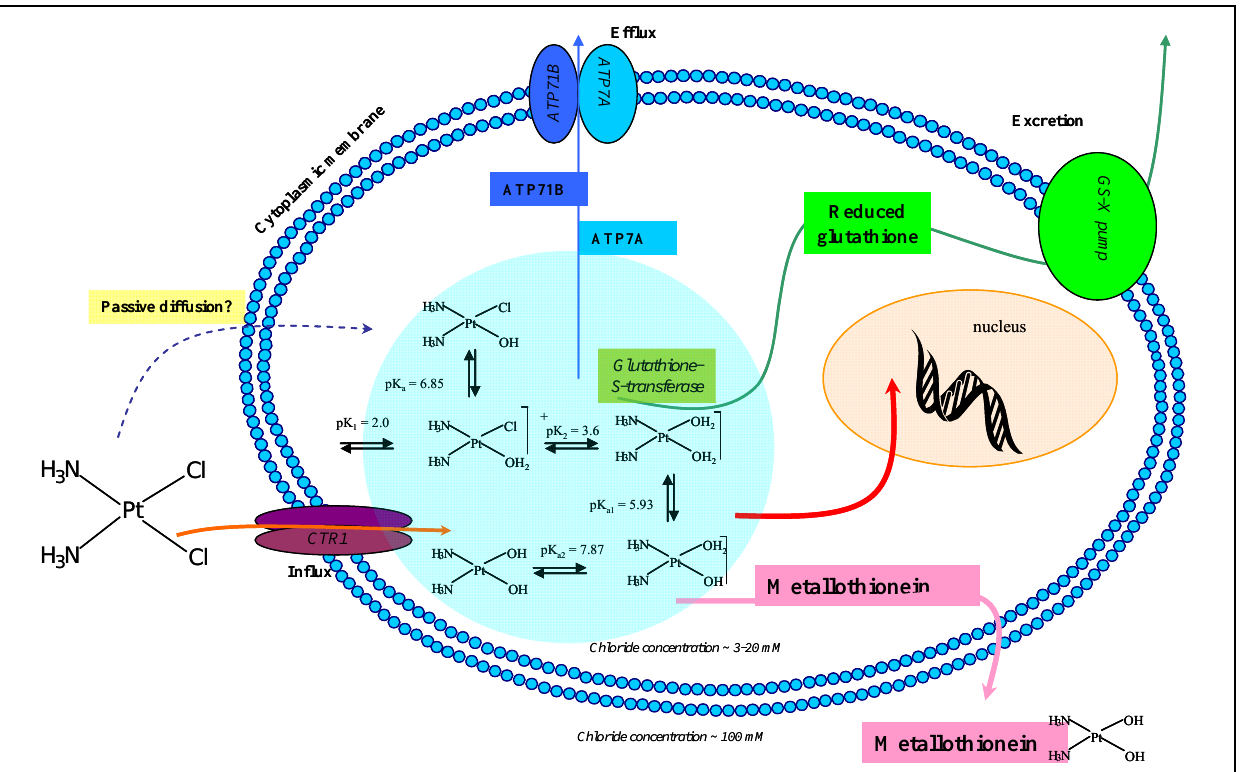
Figure 1. A simplified scheme of the possible reactions in a cell after cisplatin entry. Cisplatin can enter a cell through channels (e.g. CTRI) or also by the passive diffusion. In the cell, aqua complexes of cisplatin are able to react with DNA especially due to changes in chloride ion concentrations. However, cisplatin concentration in a cell is lowered by the active efflux through ATP pump and by reactions with glutathione and metallothionein. The scheme was proposed and modified according to